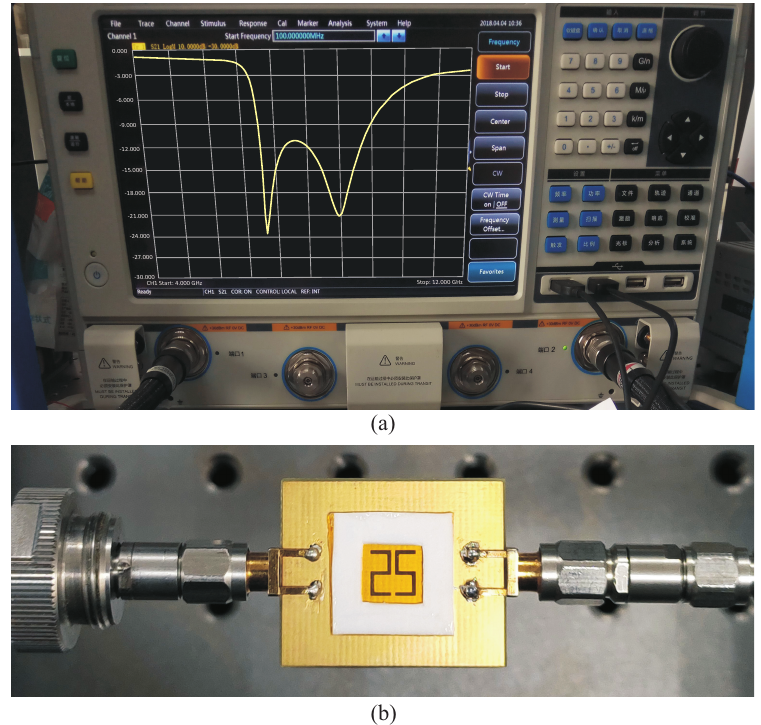
Figure 4. ( a ) Photograph of CEYEAR AV3672D series vector network for measurement, ( b ) fabricated prototype of the complementary metaresonator sensor.